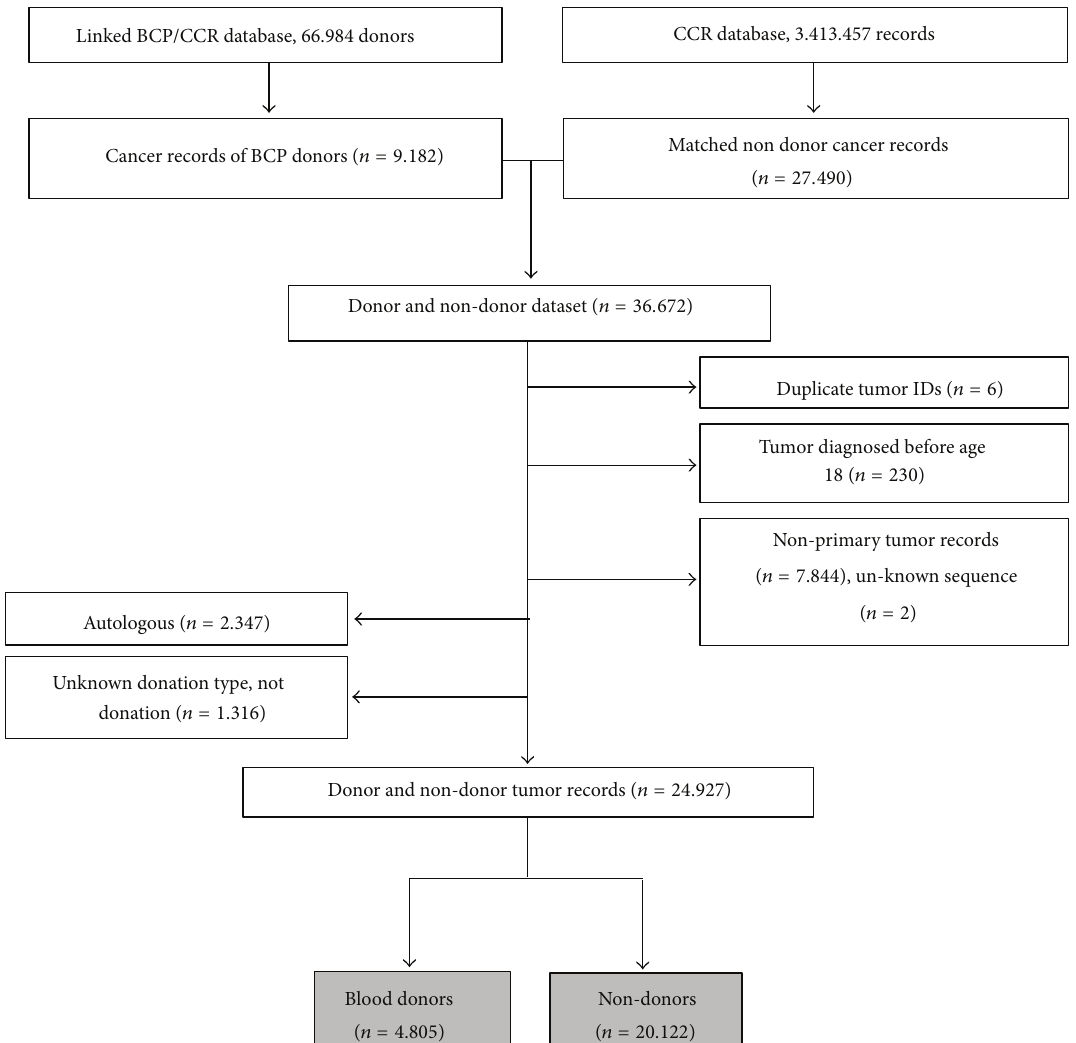
Figure 2: Flow diagram of donor and non-donor cancer records used for survival analysis, BCP: Blood Centers of the Pacific, CCR: California Cancer Registry, San Francisco, CA, 1991–2009. Note: study population for survival analysis is shown in